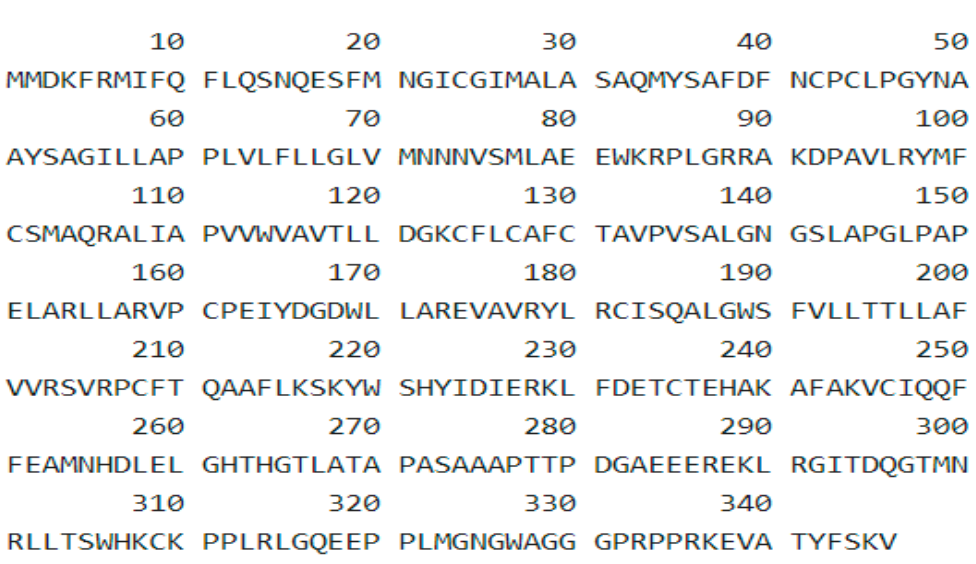
Figure 3. GOR4 result (dark blue is denoting alpha helix, light blue is denoting pi helix, dark pink is denoting beta bridge, red is denoting extended strands). The Self-Optimised Prediction Method with Alignment (SOPMA) is an Expasy server protein-aided secondary structure prediction tool. Using consensus estimation from several alignments, the algorithm contributes to significant advances in protein secondary structure. Analysing SOPMA, CALHM1 consisted of 182 alpha helix, 34 ex- tended strands, and 119 random coils as shown in Figure 4.